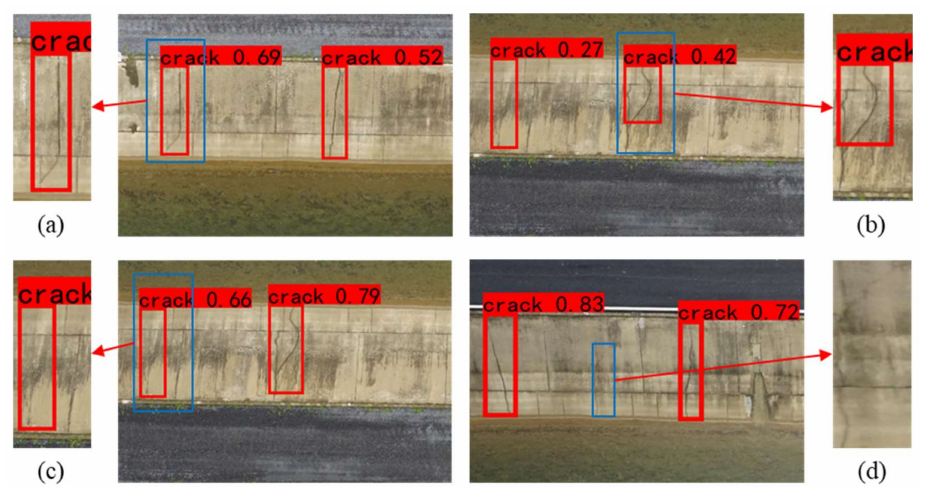
Figure 13. Crack-detection problem diagram. ( a ) Crack-detection frame is too large. ( b ) Crack-detection box is too small. ( c ) There is no crack in the field, and the test result shows a crack. ( d ) Cracks in the field and no cracks in the test results.